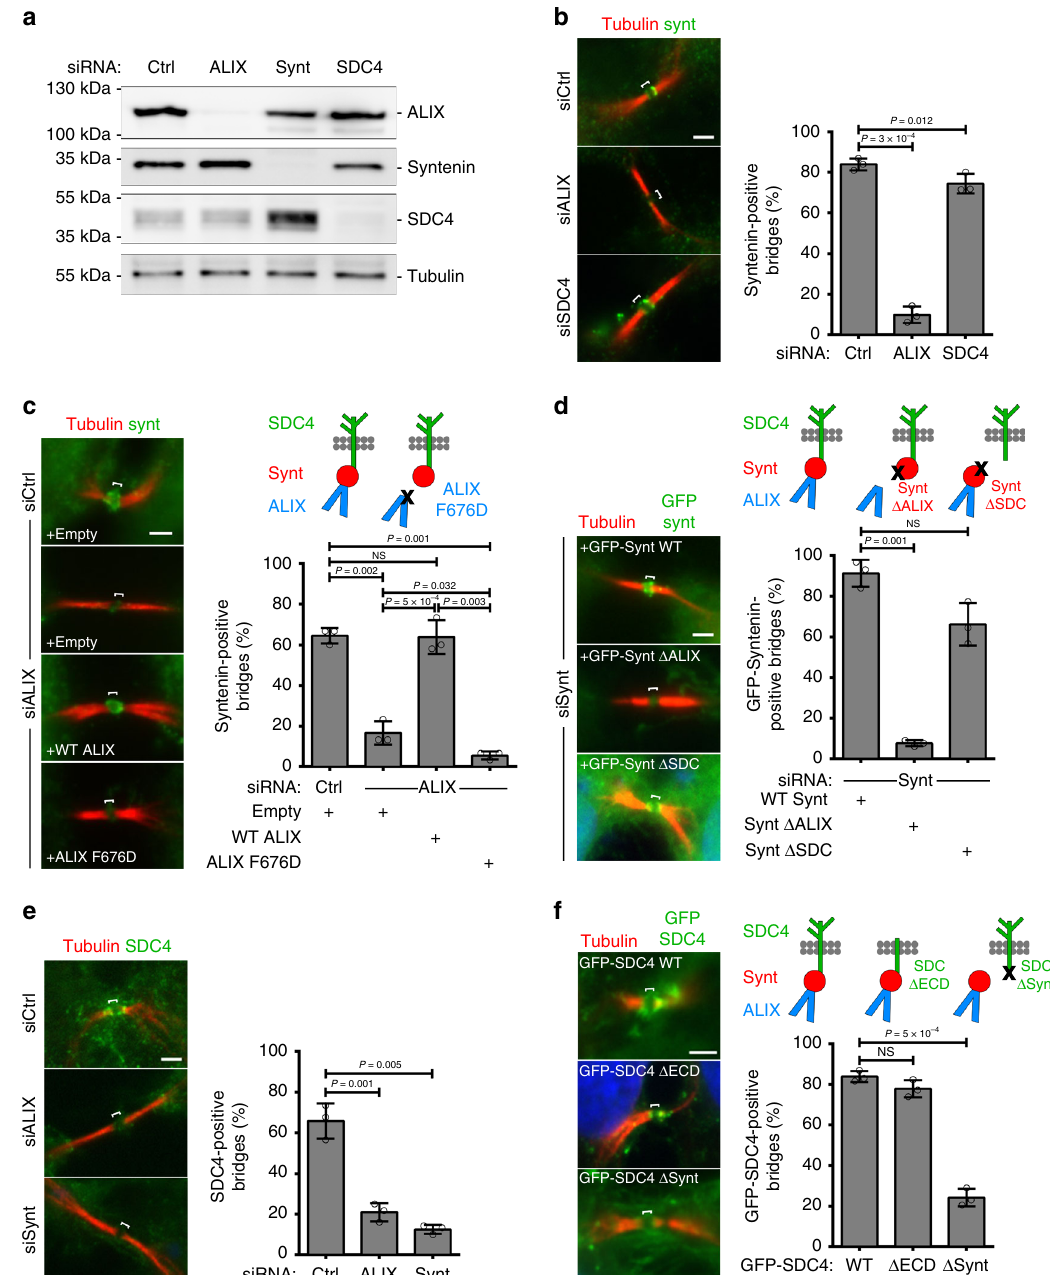
siRNA: Fig. 3 ALIX directly recruits syntenin and syntenin directly recruits syndecan-4 to the cytokinetic bridge. a Western blots of protein extracts from cells treated with control, ALIX, syntenin (Synt), or syndecan-4 (SDC4) siRNAs revealed with the indicated antibodies. Loading control: β -tubulin. b Left panels: representative intercellular bridges from control, ALIX or syndecan-4 siRNA-treated cells stained for acetylated-tubulin and endogenous syntenin, as indicated. Right panel: percentage (mean ± SD) of bridges positive for syntenin after control, ALIX and syndecan-4 depletion. n = 31 – 53 cells, N = 3 independent experiments. ( c ) Left panels: representative intercellular bridges from control- or ALIX-depleted cells expressing either control (Empty), wild- type ALIX or ALIX F676D mutant (unable to interact with syntenin), and stained for acetylated-tubulin and endogenous syntenin, as indicated. Right panel: percentage (mean± SD) of bridges with syntenin recruitment in the corresponding conditions. n = 25 – 31 cells, N = 3 independent experiments. d Left panels: representative intercellular bridges from syntenin-depleted cells expressing either GFP-syntenin wild-type, GFP-syntenin Δ ALIX (unable to interact with ALIX) or GFP-syntenin Δ SDC (unable to interact with syndecan-4). Acetylated-tubulin and GFP signals are shown. Right panel: percentage (mean ± SD) of bridges with GFP-tagged syntenin recruitment in the corresponding conditions. n = 14 – 33 cells, N = 4 independent experiments. e Left panels: representative intercellular bridges from control, ALIX or syntenin siRNA-treated cells and stained for acetylated-tubulin and endogenous syndecan-4, as indicated. Right panel: percentage (mean ± SD) of bridges positive for syndecan-4 after control, ALIX and syntenin depletion. n = 30 – 40 cells, N = 3 independent experiments. f Left panels: representative intercellular bridges from cells expressing either GFP-syndecan-4 wild-type, GFP-syndecan-4 Δ ECD (deleted from its entire extracellular domain) or GFP-syndecan-4 Δ Synt (unable to interact with syntenin). Acetylated-tubulin and GFP signals are shown. Right panel: percentage (mean ± SD) of bridges with GFP-tagged syndecan-4 recruitment in the corresponding conditions. n = 23 – 41 cells, N = 3 independent experiments. b – f Scale bars: 2 μ m. Brackets mark the midbody. Panels b – f : one-sided Student ’ s t tests. NS non signi fi